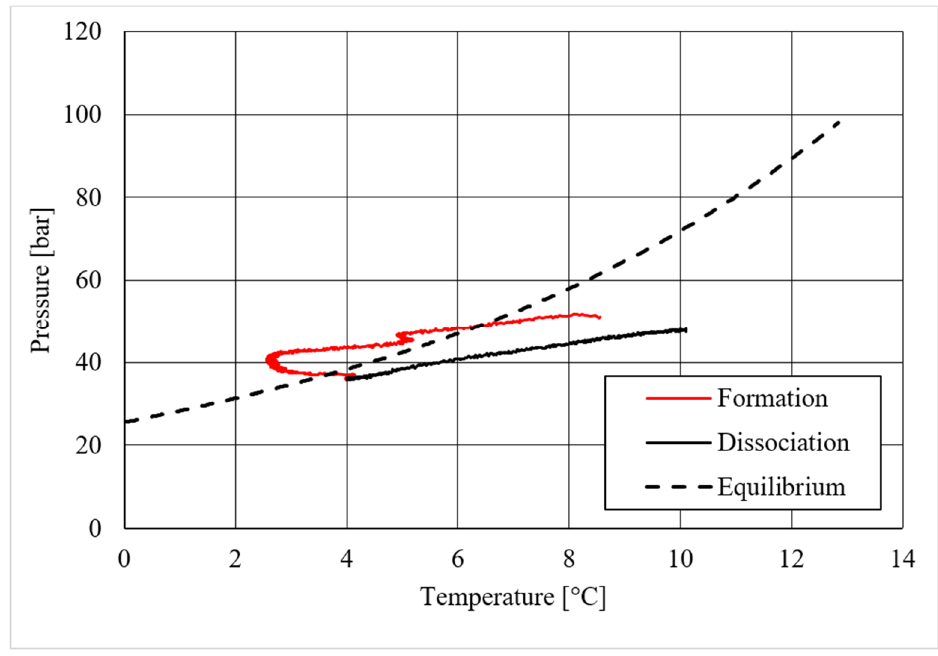
Figure 8. Pressure vs. temperature, describing methane hydrate formation in the presence of 4.23 wt.% CuSn12 powder.